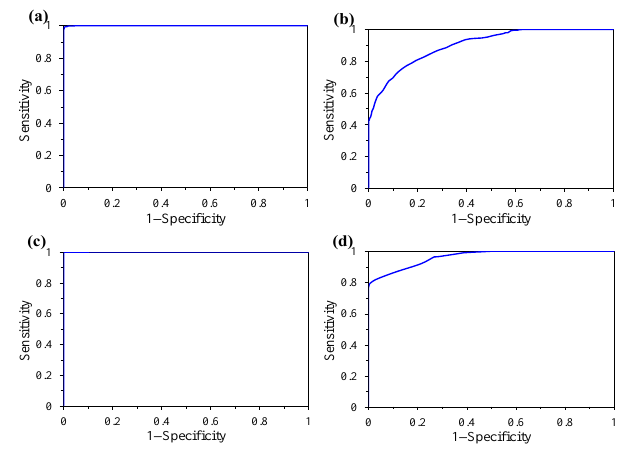
Figure 7. ROC curve analysis of LS-SVM classifier performance on the basis of training set. (a) and (c) are the result of BH-corrected image, and (b) and (d) are the outcome of BH-uncorrected